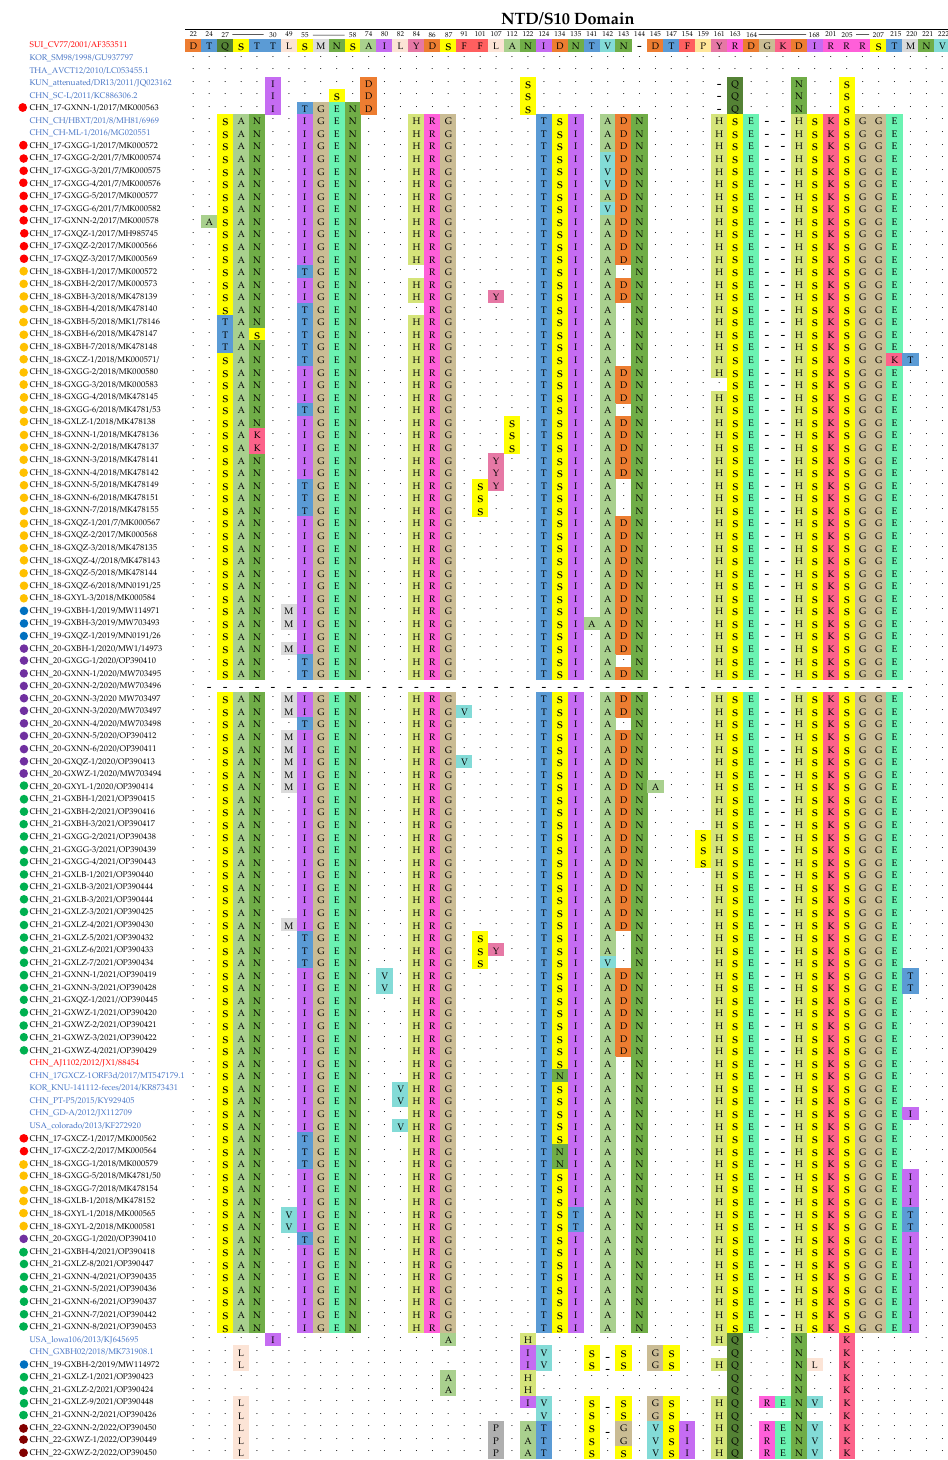
Figure 5. Amino acid variations in the neutralizing epitope regions of the partial S1 protein between the different subgroups. All the insertions, deletions and mutations in the epitope region, NTD/S10, are indicated. The vaccine strain CV777 (GenBank accession no. AF353511) was set as a reference; the two vaccine strains are highlighted in red, while the representative strains in each sub - group are colored in blue. The dots represent the consensus amino acids and the red boxes indicate the positions of insertions and deletions.